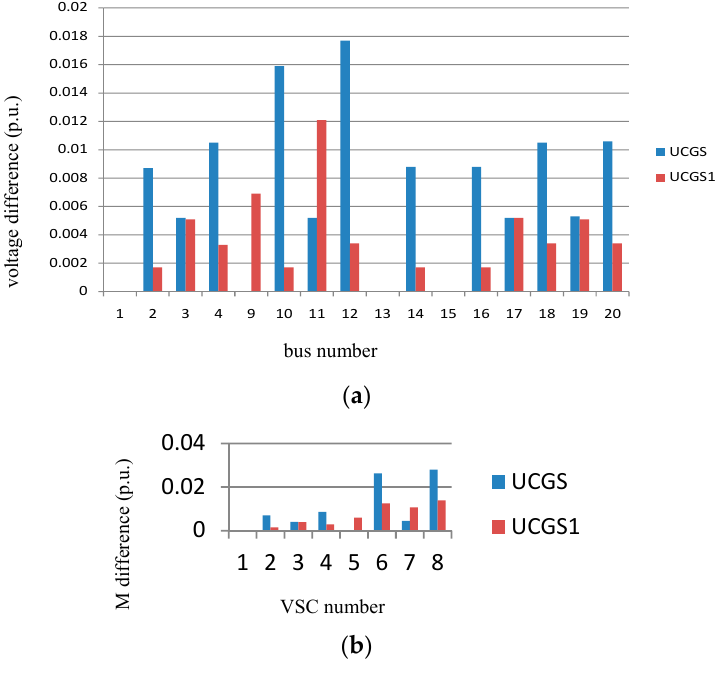
Figure 10. Voltage and M difference for UCGS and UCGS1. ( a ) DULVIs for the UCGS and UCGS1; ( b ) DULMIs for the UCGS and UCGS1.